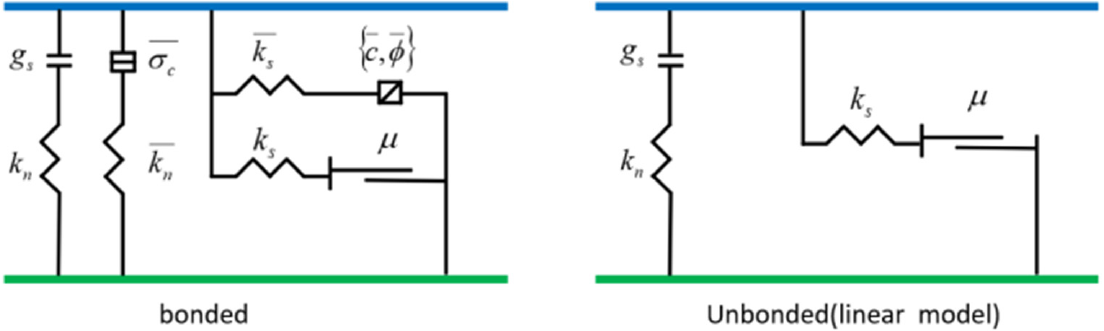
Figure 2. Parallel bonding models